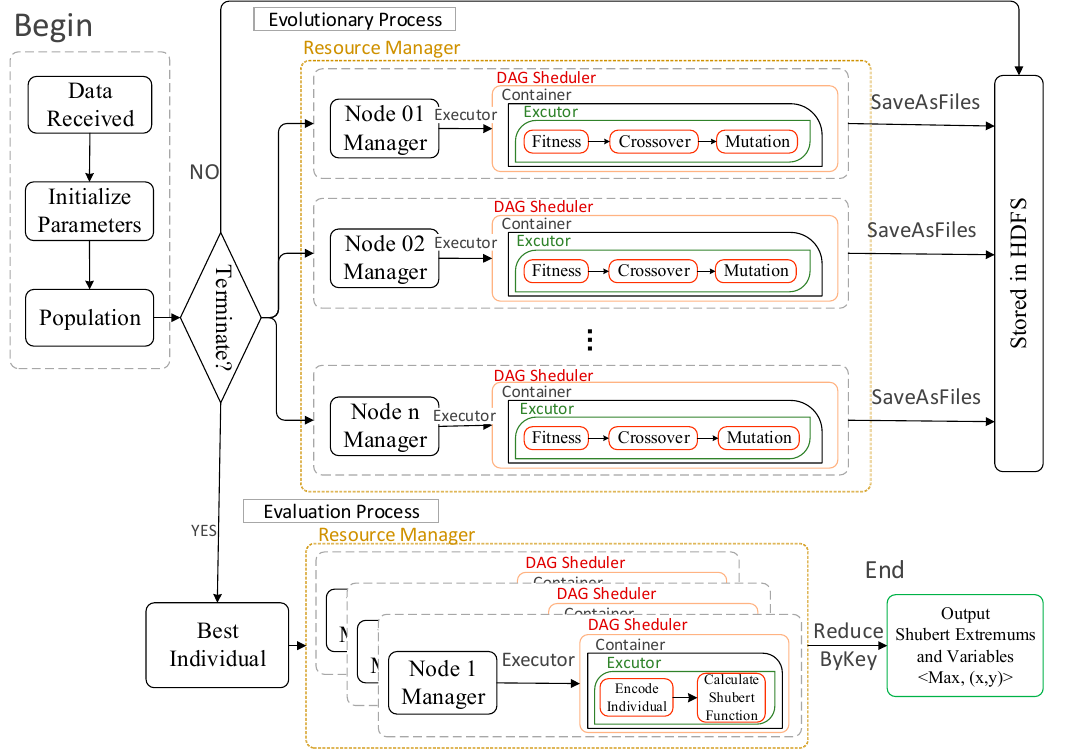
Figure 6. Spark-based parallel GAESMPF.